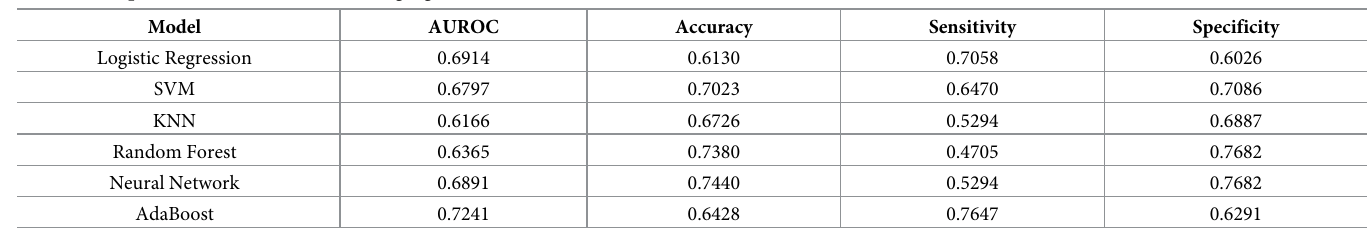
Table 2. The performance of machine learning algorithms.